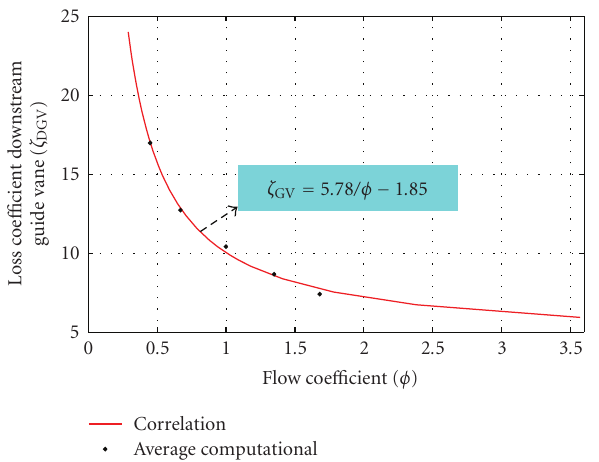
Figure 4: Correlated downstream guide vane loss coe ffi cient versus flow coe ffi cient [10].